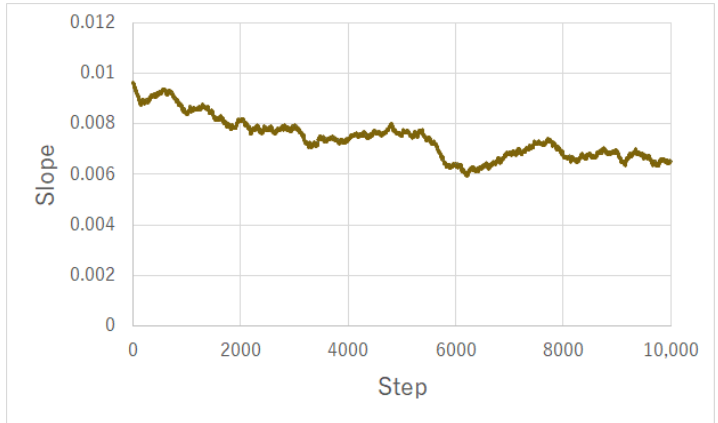
Figure 2. The value of the slope changes with each step of the